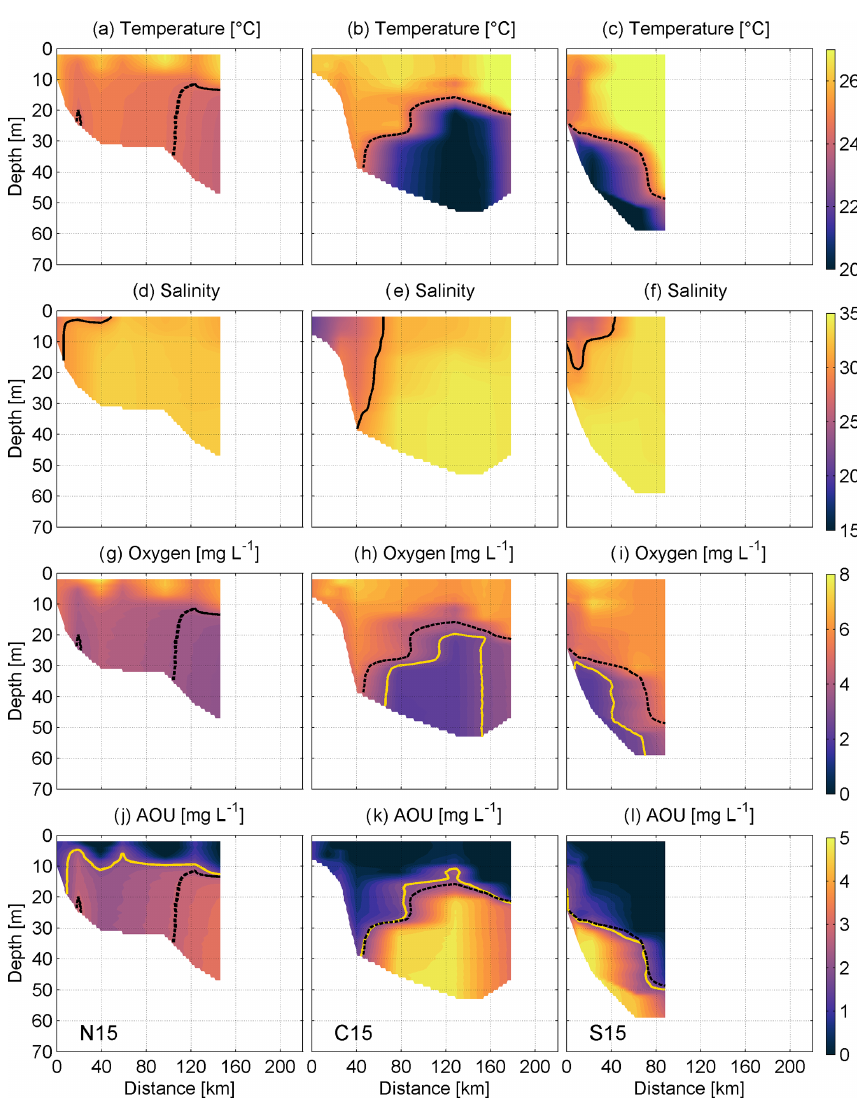
Figure 4. Vertical distributions of temperature, salinity, density, DO concentration and apparent oxygen utilization (AOU) along sections N15, C15 and S15 in 2015 (Fig. 1). Temperature isoline 24.5 ◦ C is shown with the thicker dashed line in the temperature, oxygen and AOU plots. AOU isoline 2mgL − 1 is shown with the thicker solid line in AOU plots. The hypoxia border (3.0mgL − 1 ) is shown with a thicker solid line in oxygen plots. Locations of CTD stations are shown as crosses in the top panels. Values on the x axis indicate the distance from the westernmost point of a section (Fig.